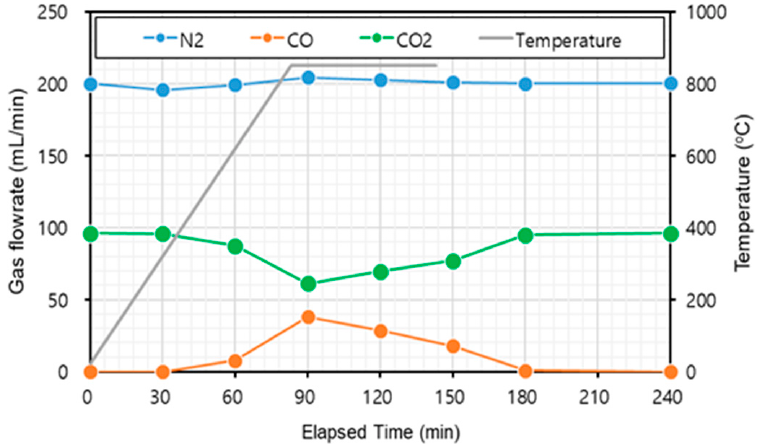
Figure 4. Changes of syngas compositions during the reaction.